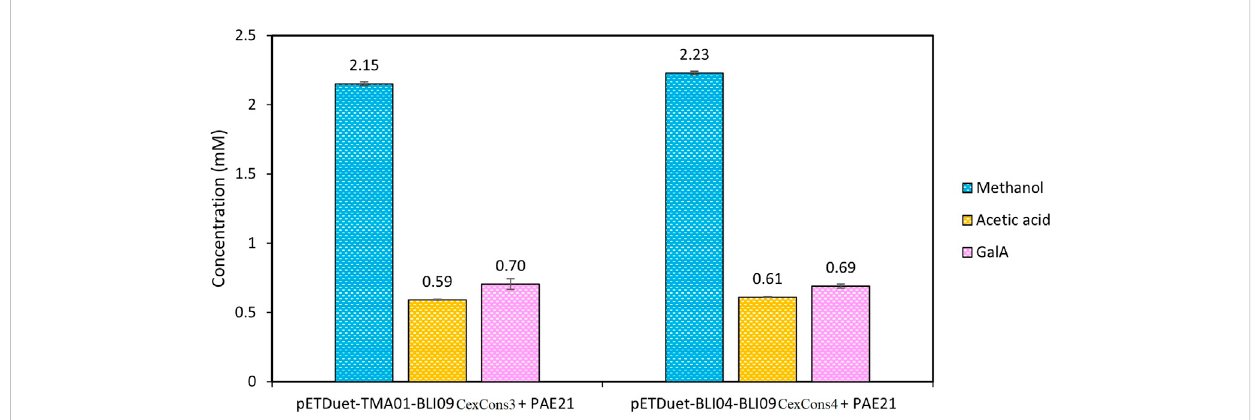
FIGURE 4 Synergistic activity of pectinases from co-expression constructs 3 and 4 along with PAE21 individually expressed using sugar beet pectin where methanol, acetic acid and GalA were quanti fi ed. The reactions were carried out at 50 ° C using 0.5% (w/v) substrate (in 100 mM phosphate pH 7), and 0.5and2 U mL − 1 ofTMA01andBLI04,respectively.TheBLI09activitywascalculatedinthevolumescontainingtheUmL − 1 ofexo-PGsmentionedbefore (SupplementaryTable S3). The results shown correspond to areaction time of 24 h.Error bars represent one standard deviation from the mean (n = 2). CexCons: co-expression construct, PAE: pectin